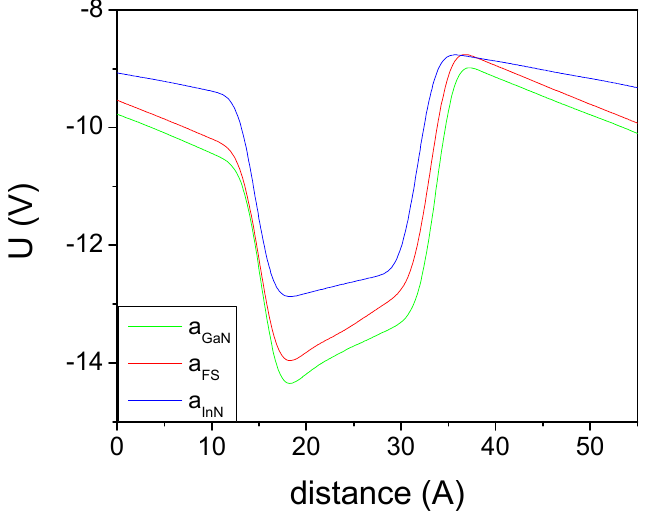
Figure 7. Electric potential profiles, obtained for 12GaN-6InN atomic layers superlattice using GGA-1/2 approximation. The line represents: GaN—structure strained to GaN, a lattice constant; FS—freestanding lattice; InN—structure strained to InN, a lattice constant.